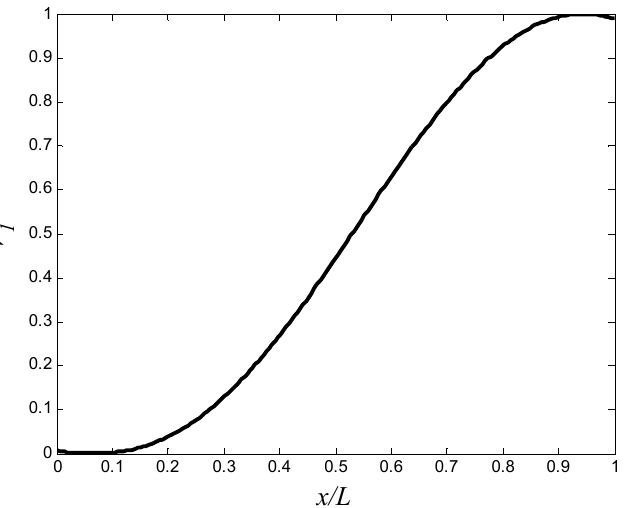
Figure 5. The optimal aluminum volume fraction profile which maximizes the fundamental frequency (trigonometric law, Equation (2)).